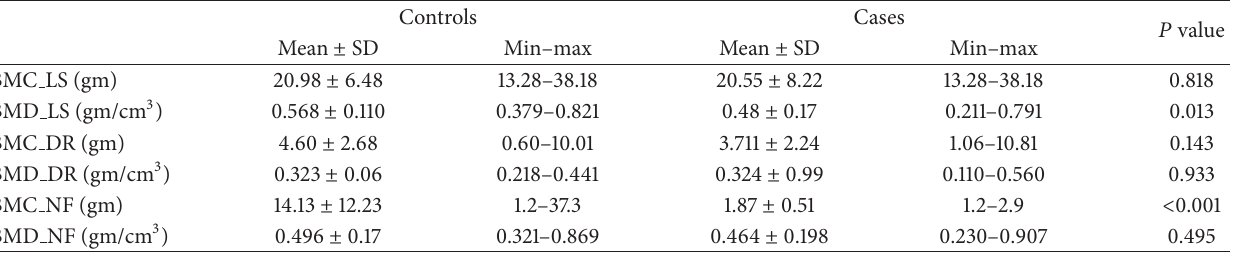
Table 1: Bone mineral content (BMC) and bone mineral density (BMD) in cases and control at lumbar spine (LS), distal radius (DR), and neck of femur (NF).